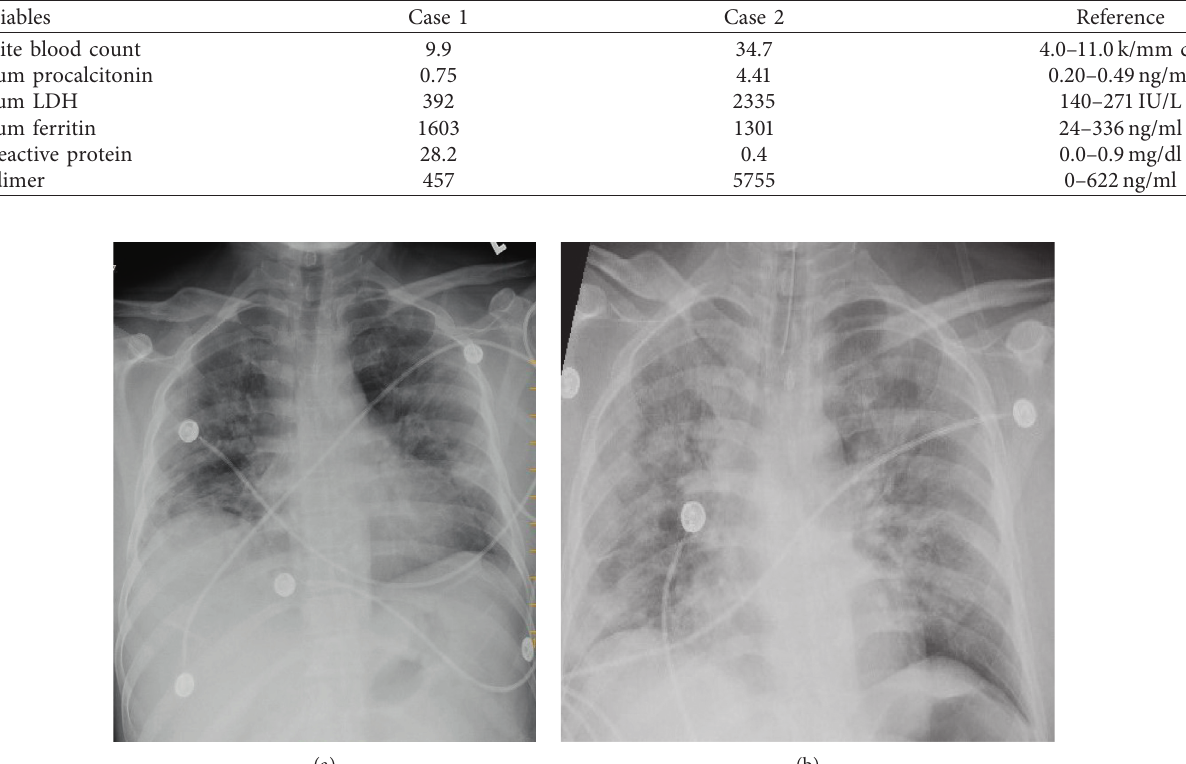
Table 1: Comparison of laboratory variables of case 1 and case 2.